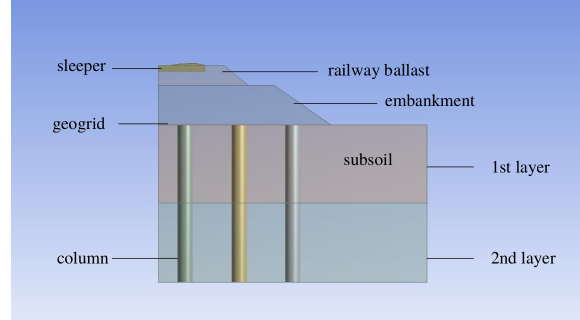
Figure 5. The scheme of layers in the model of reinforced earthworks.